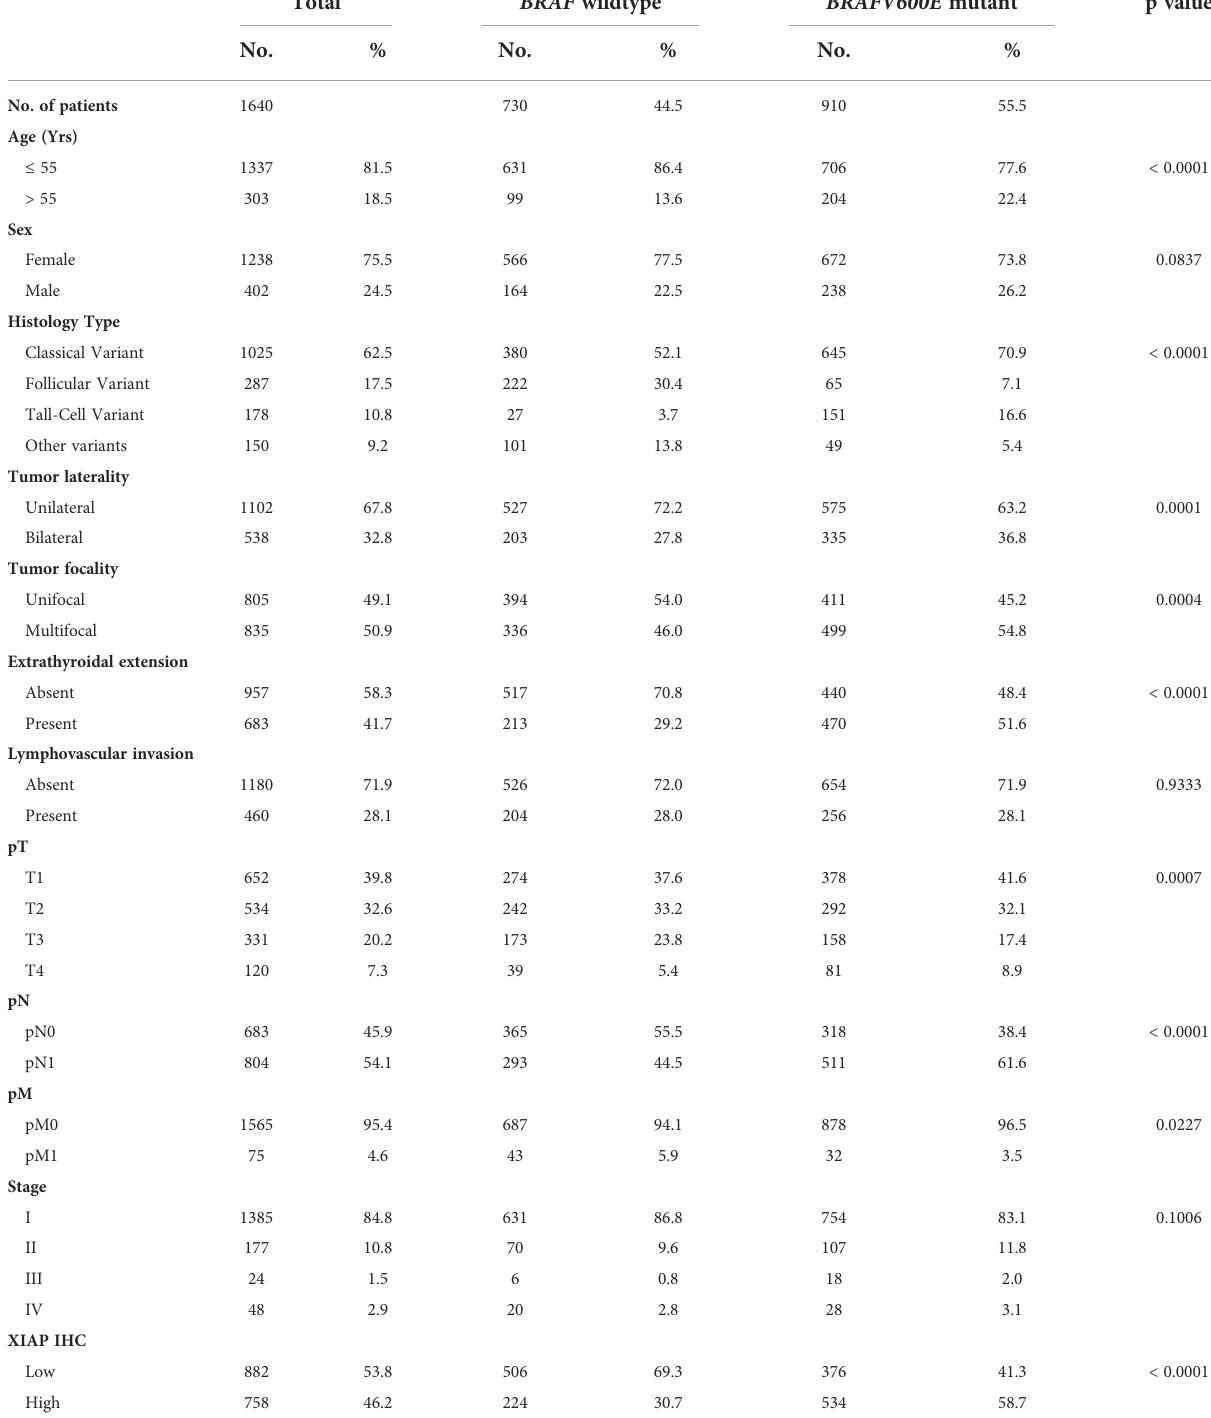
Total BRAF wildtype BRAFV600E